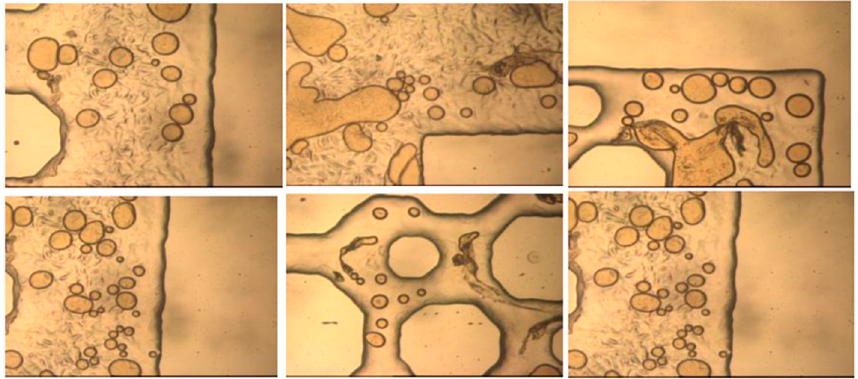
Figure 12. Emulsions observed in the micromodel experiments during nanofluid flooding processes [34].